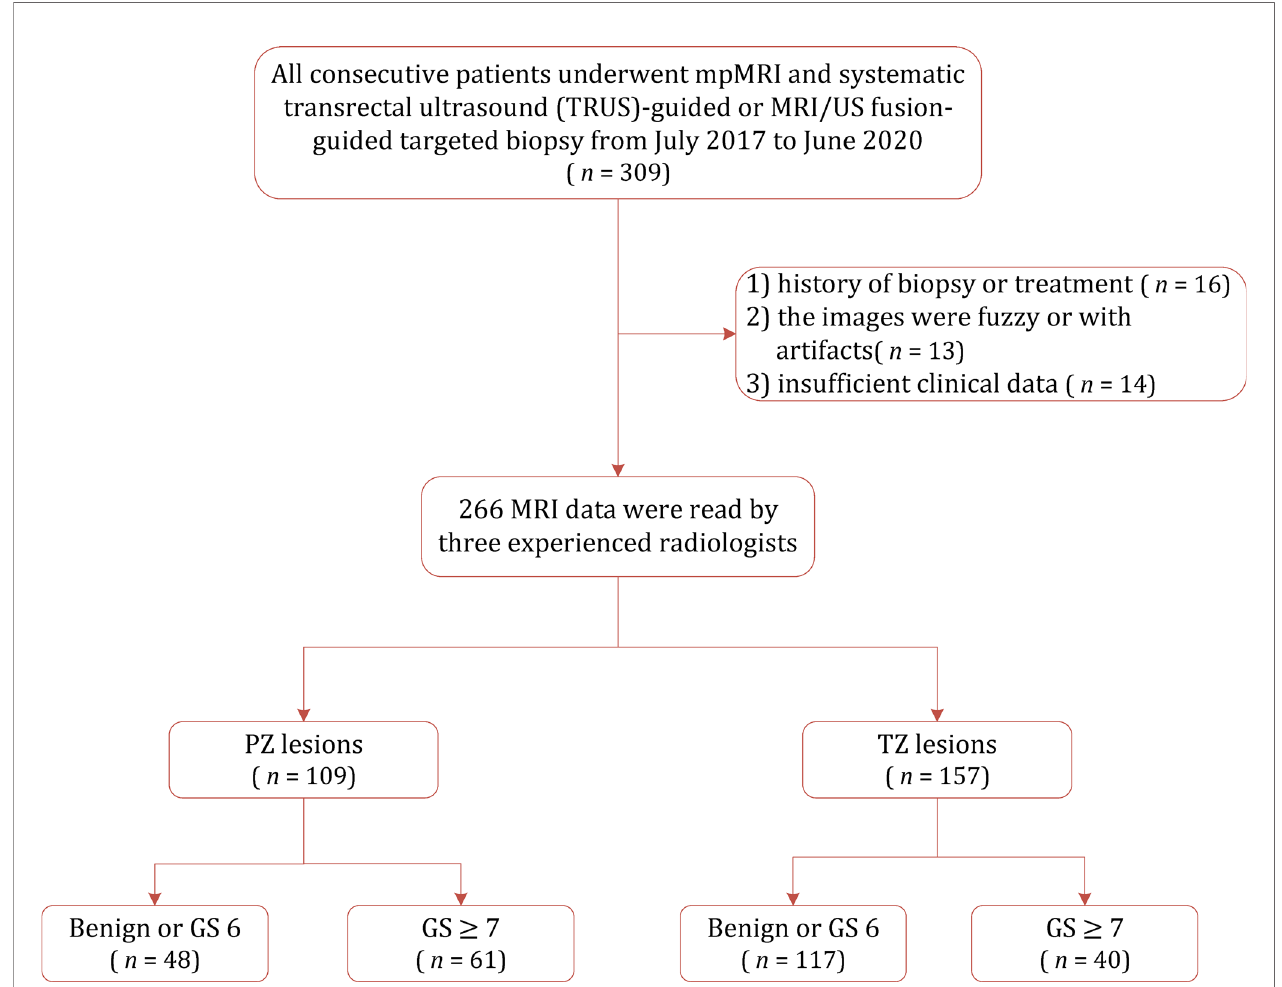
FIGURE 1 | Flowchart of the study population with the exclusion criteria. GS, gleason score; PZ, peripheral zone; TZ, transition